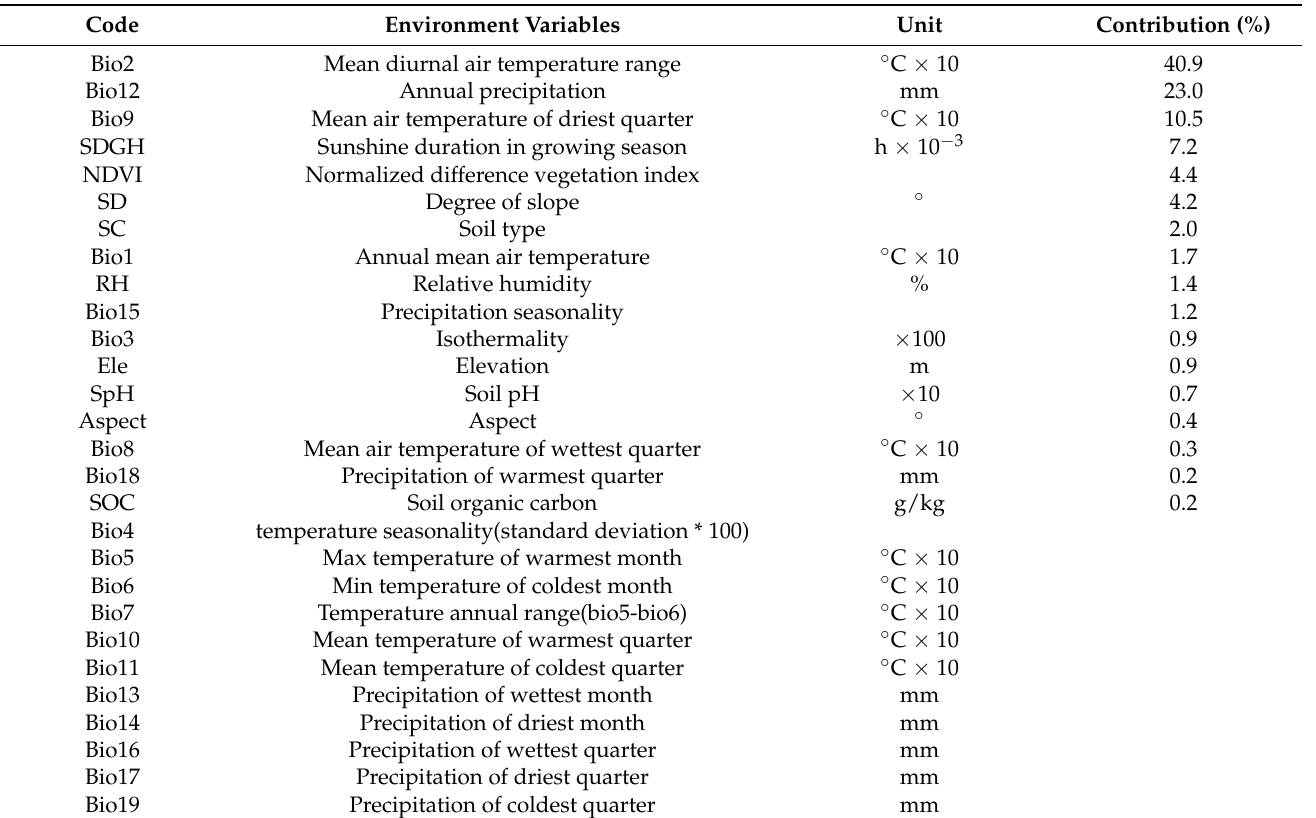
Table 1. Environment factors used to predict the potential distribution of Cinnamomum camphora